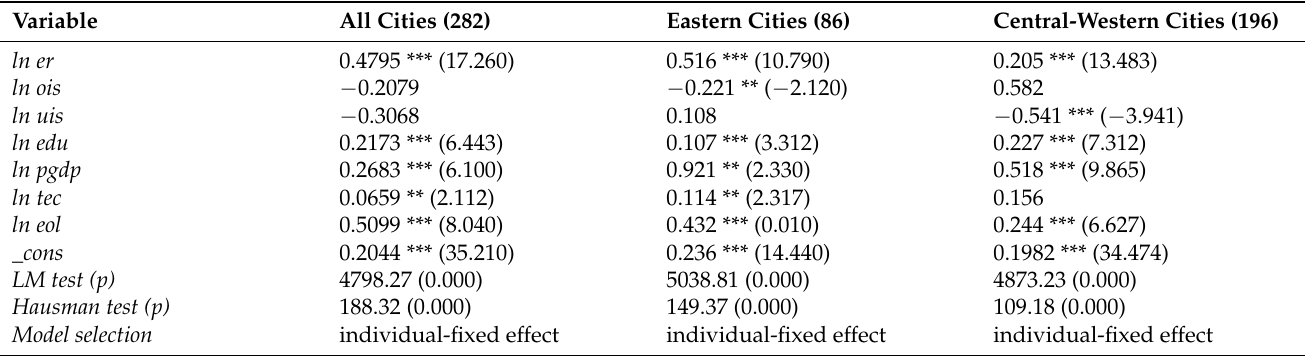
Table 2. Results of the benchmark